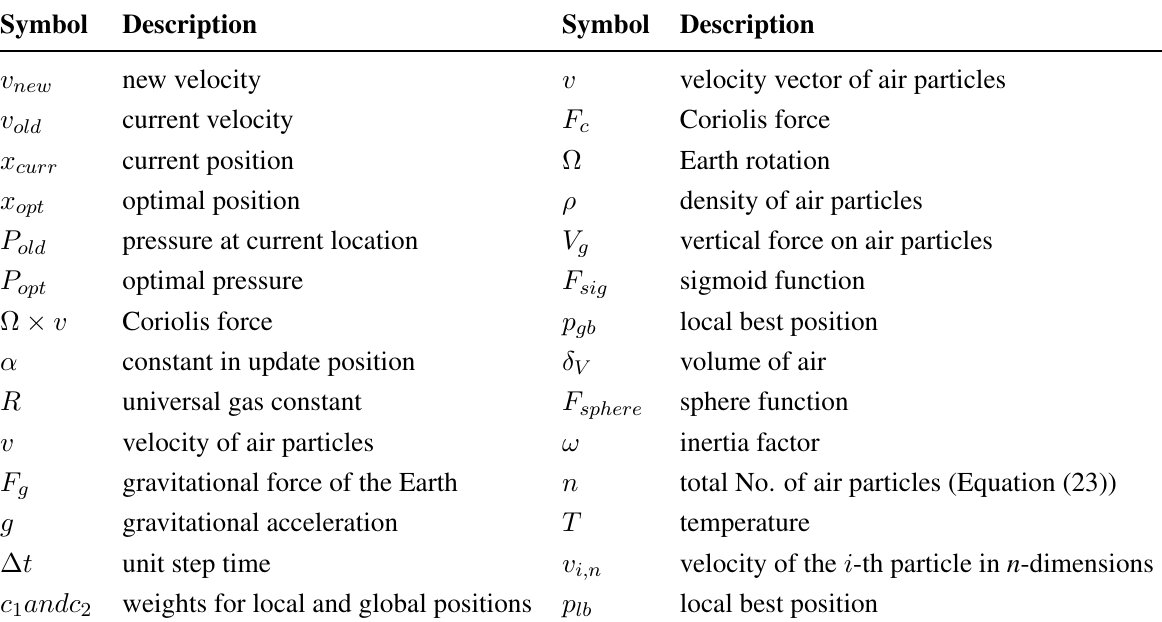
Table 2. Symbols used in the wind-driven optimization (WDO) and PSO algorithms.